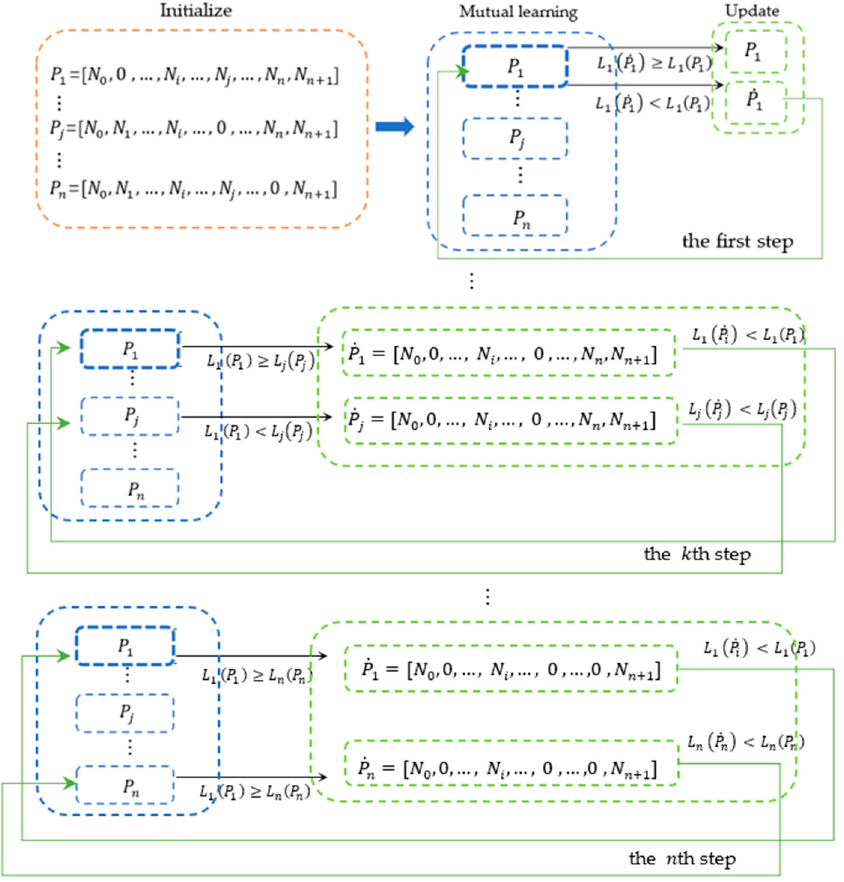
Figure 6. The mutual learning process of